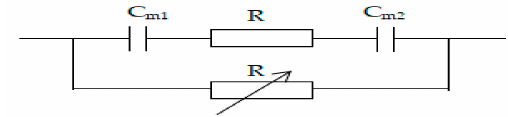
Figure 3. Schematic of an equivalent circuit diagram of the unit used to measure membrane